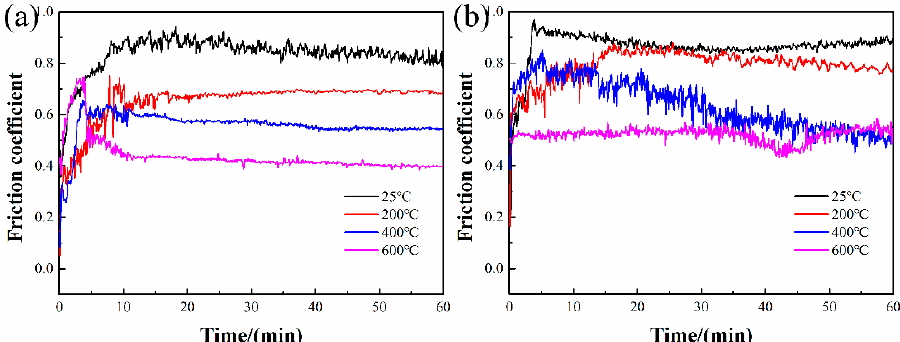
Figure 2. The coefficient of friction (COF) curves of the two kinds of materials during sliding wear testing at different temperatures: ( a ) CoCrAlYTa-10%Al 2 O 3 coating; ( b ) H13 steel.